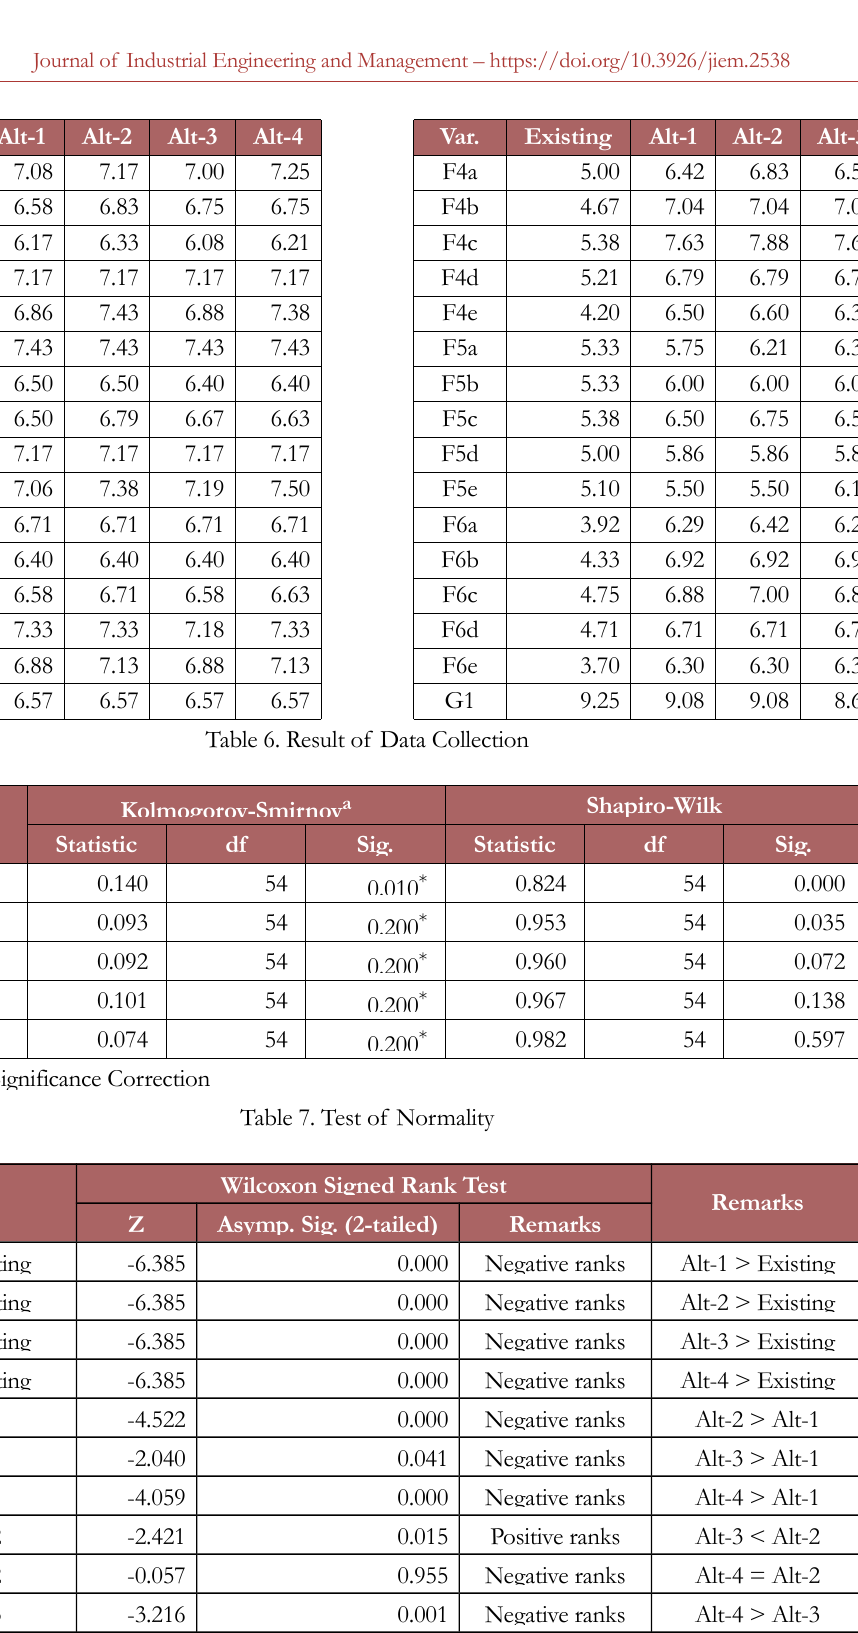
Table 8. Paired-Test Wilcoxon Signed Rank